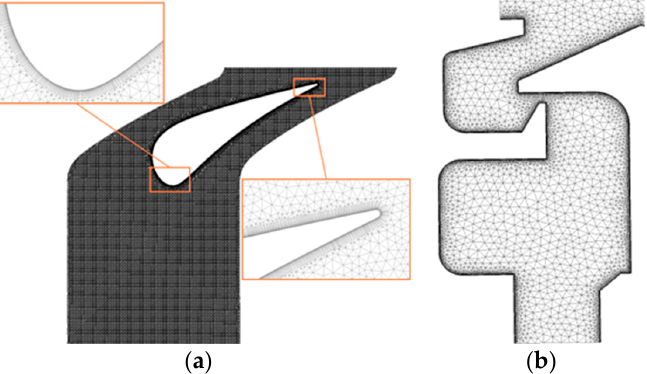
Figure 4. Computational mesh in the fluid domain: ( a ) main flow passage; and ( b ) sealing cavity.